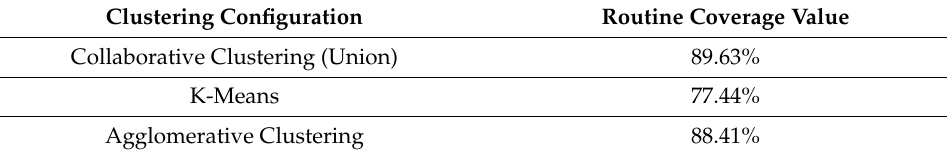
Table 5. Coverage Metric